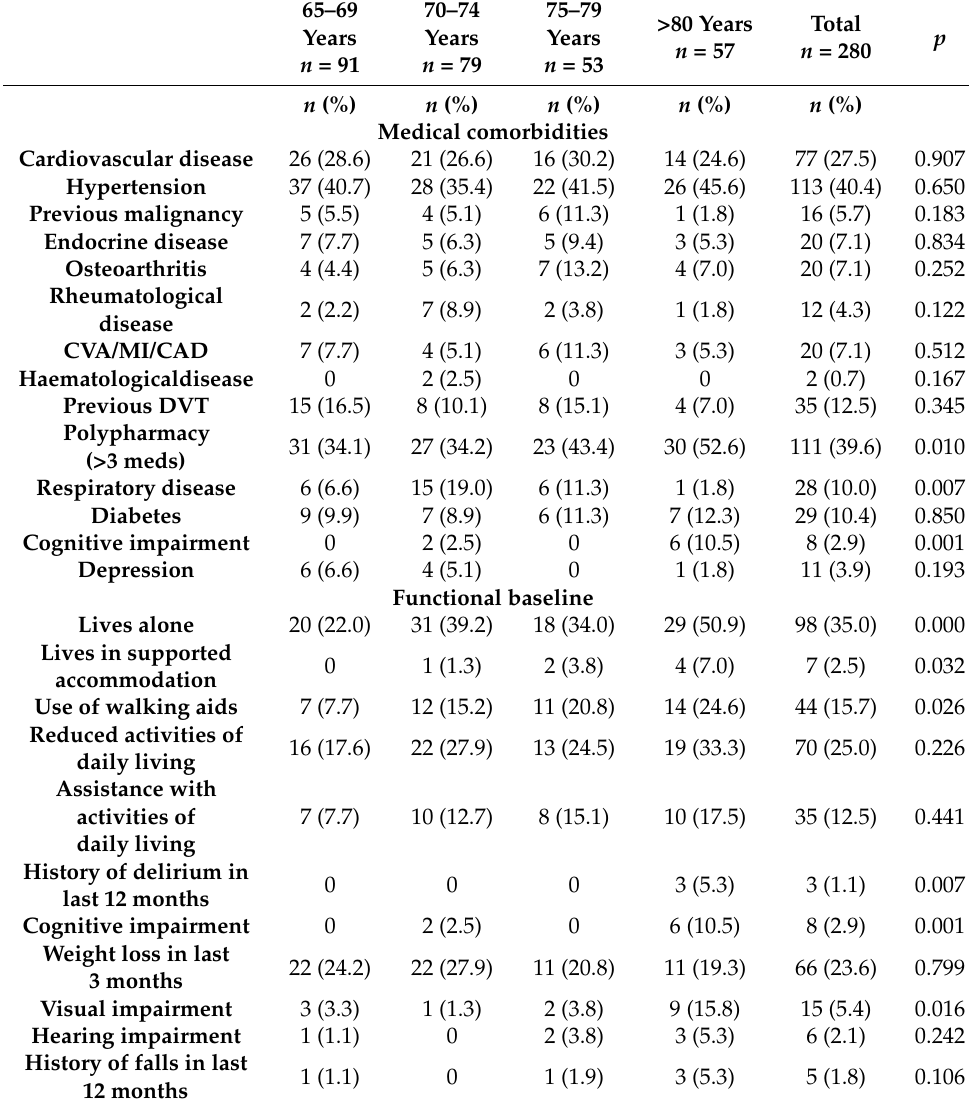
Table 2. Patient characteristics. Medical comorbidities and functional status at